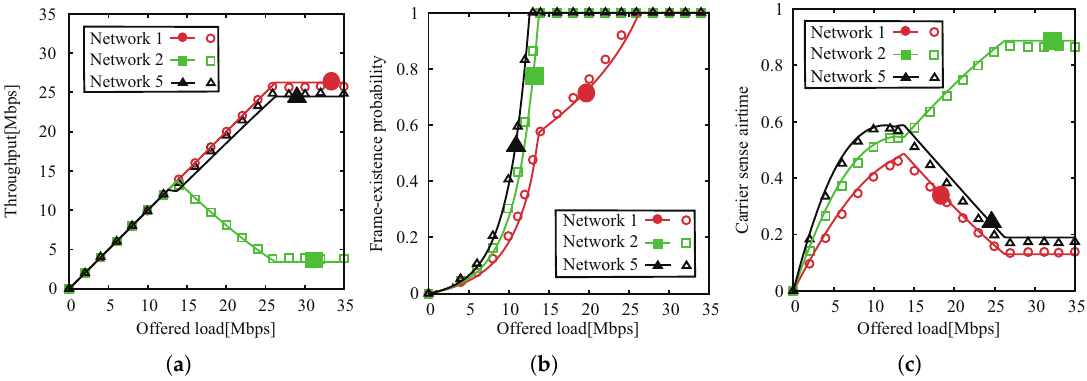
Figure 7. Network characteristics of analytical (lines) and simulation (plots) results as a function of the offered load for Scenario 3. ( a ) Throughput. ( b ) Frame-existence probability. ( c ) Carrier-sense